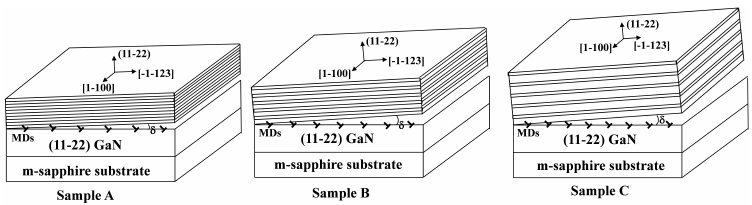
Figure A1. Schematic views of different InGaN/GaN superlattice epilayers grown on semipolar (1122) GaN showing the misfit dislocations and tilting